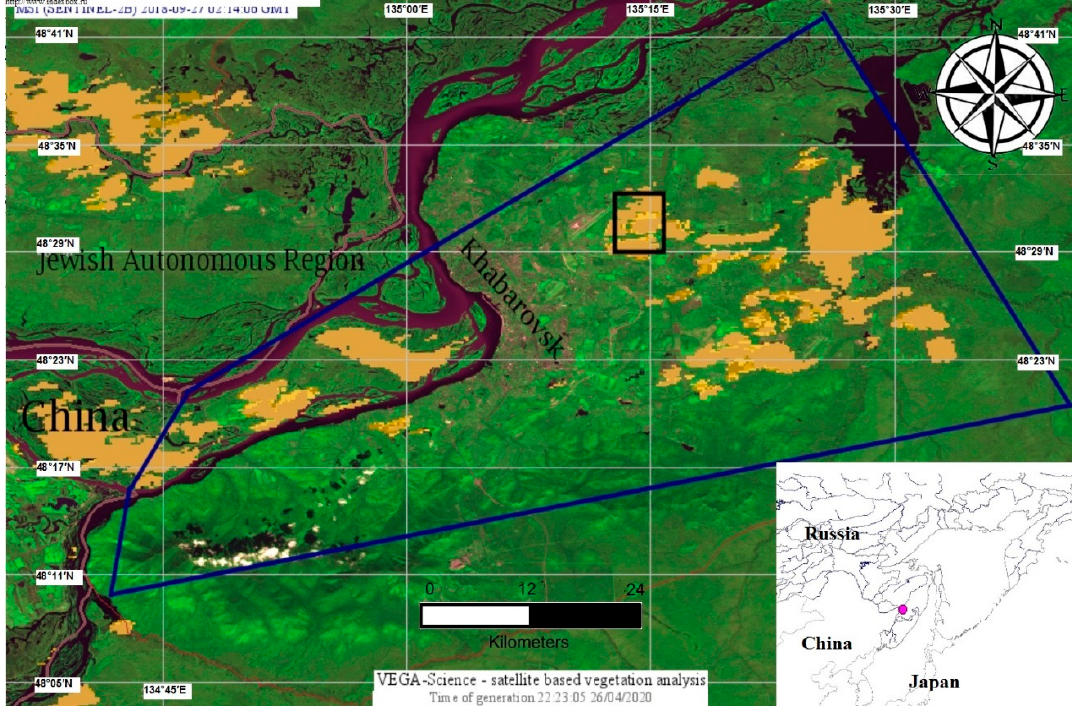
Figure 1. Location of the study area.